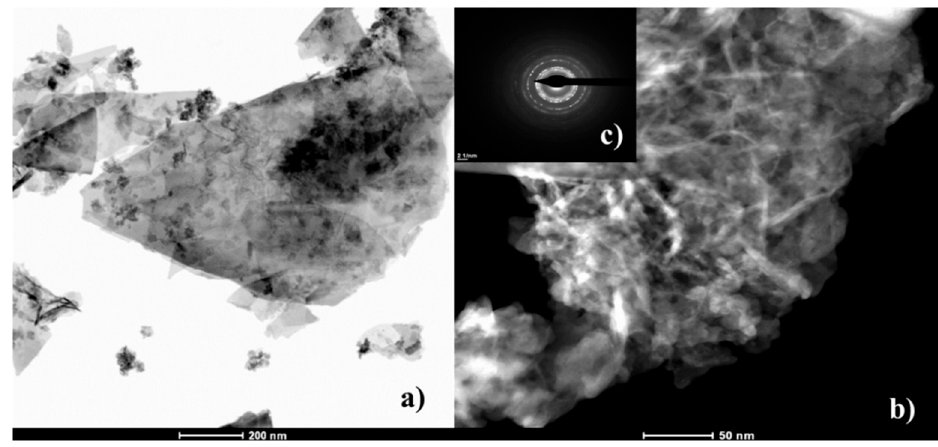
Figure 3. HRTEM images, ( a ) an ( b ), and SAED image ( c ) of 5%rGO/Bi.